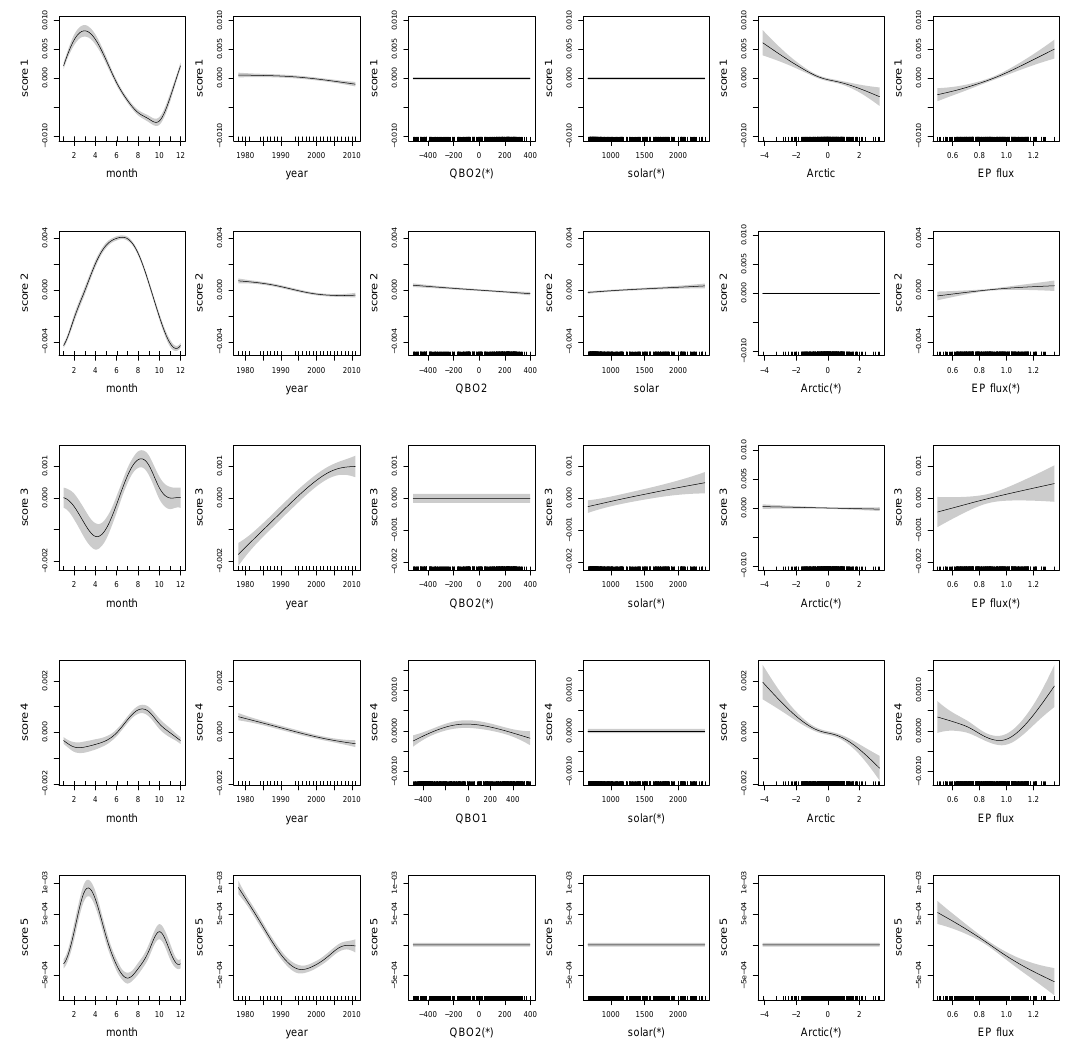
Fig. 7. Fitted smooth curves (black solid lines) and their 95% Bayesian confidence intervals (shaded areas) from AMMs of Arosa for selected covariates (ENSO for all scores, and QBO2 for score 4, as well as QBO1 for scores 1, 2, 3 and 5, are excluded, as none of these covariates are significant; see Table 1). The associated PC score and the covariate are marked as x and y labels. When the associated covariate is insignificant under the 5% significance level, ( ∗ ) is added to the x label. The unticked years in the fitted curves of year represent volcanic periods omitted from our analysis.